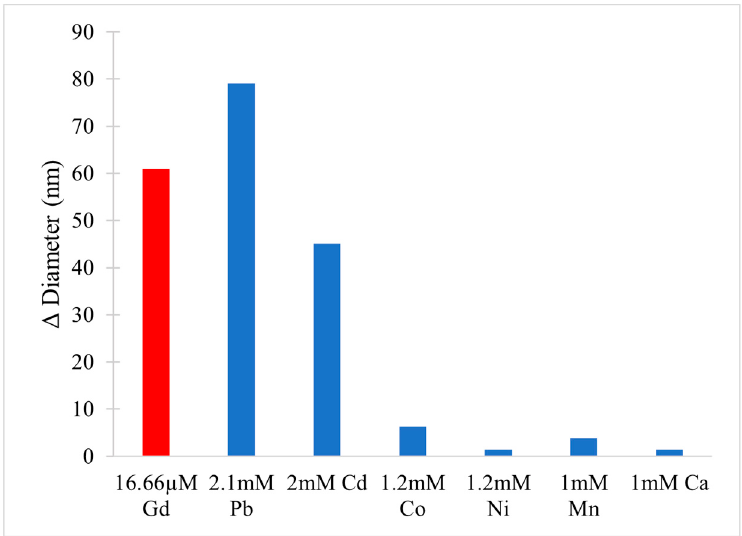
Figure 14. Change in size of Brain Polar Extract liposomes in the presence of various heavy metals. Measured by DLS.